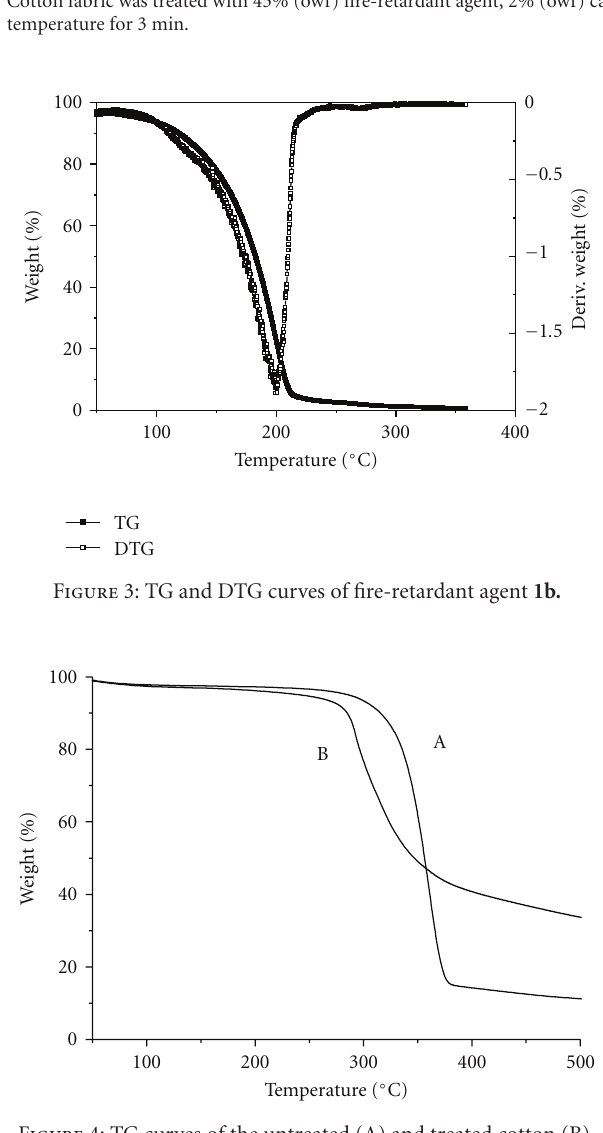
Figure 4: TG curves of the untreated (A) and treated cotton (B).